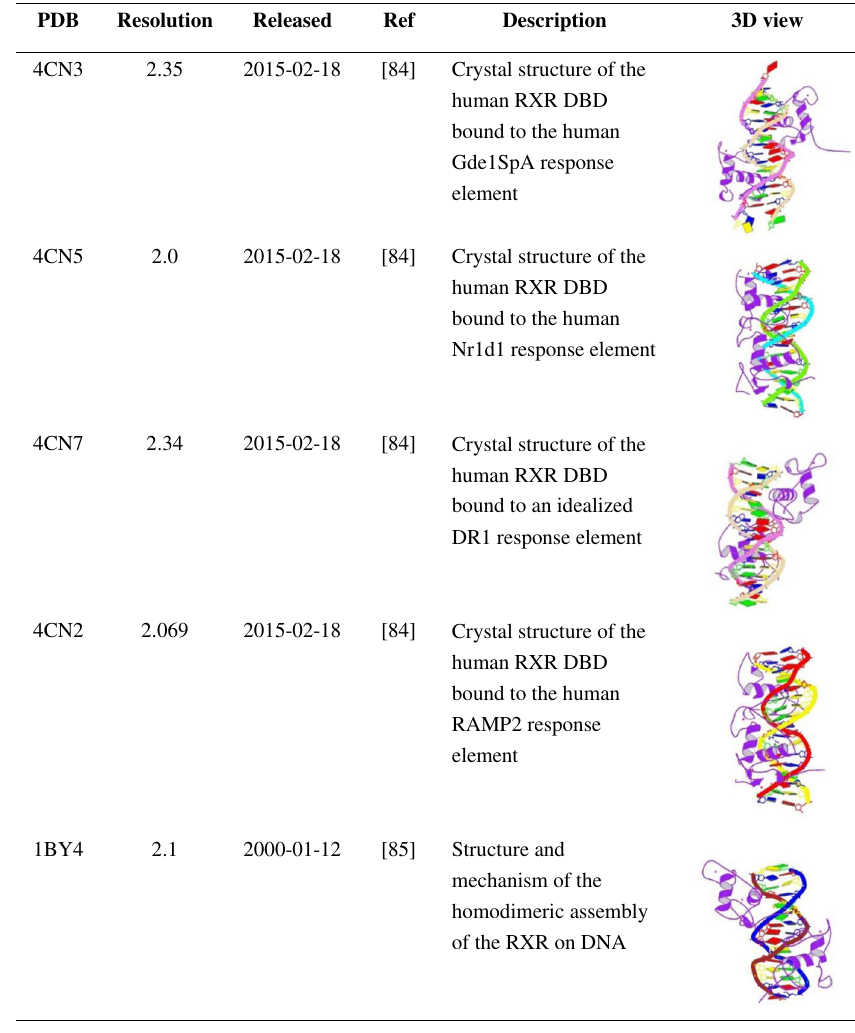
Table 1 The 3D structure of RXR α and DNA [84, 85]